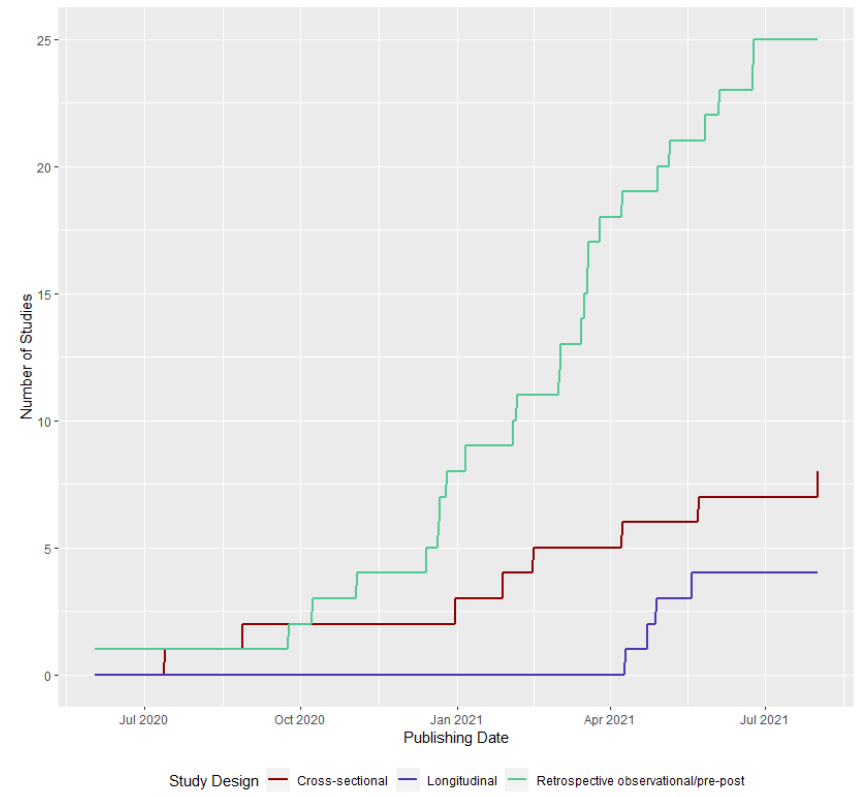
Figure 2. Study designs of selected articles by publishing